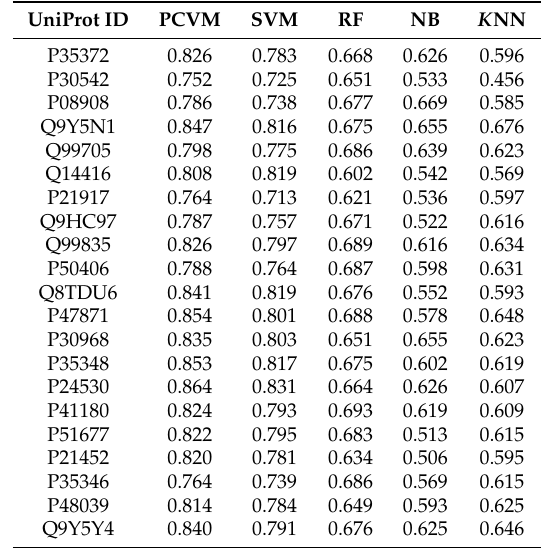
Table 4. Performance comparison of target prediction methods in terms of Recall. Scores for the external test set.